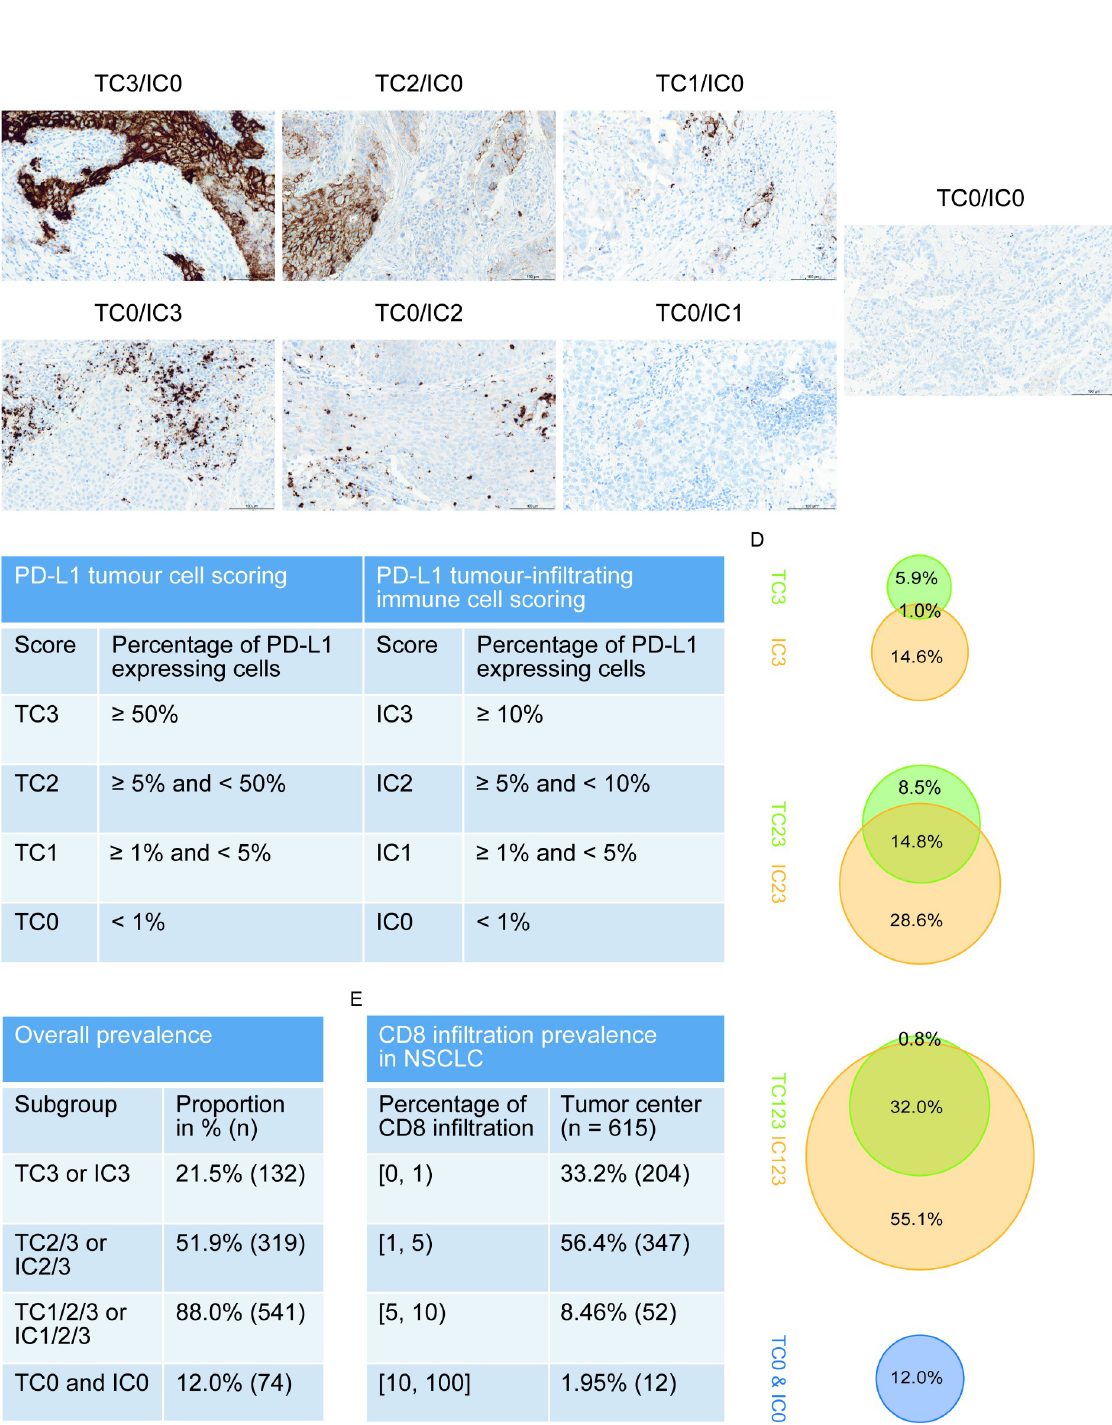
PLOS ONE | https://doi.org/10.1371/journal.pone.0216864 May 24,